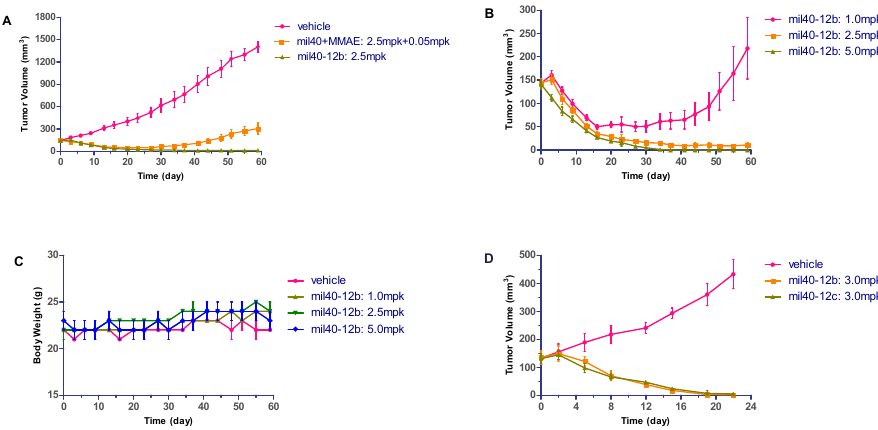
Figure 7. Xenograft studies of VA-based ADC (mil40- 12b ). NOD/SCID mice were implanted subcutaneously with BT-474 cells. When the tumors reached ~150 mm 3 , the animals were given vehicle, the mixture of mil40 and MMAE, and ADCs on: Days 0, 7, 14, and 21 ( A – C ); or Days 0, 7, and 14 ( D ). Results are shown as mean ± SD, n = 6/group. ( A ) Comparison of the efficacy of ADC in the middle dose group with the control group; ( B ) dose-efficacy dependence of the ADC treatment groups; ( C ) changes in body weight of the mice during the observation period; ( D ) comparison of the efficacy of ADCs based on VA and VC